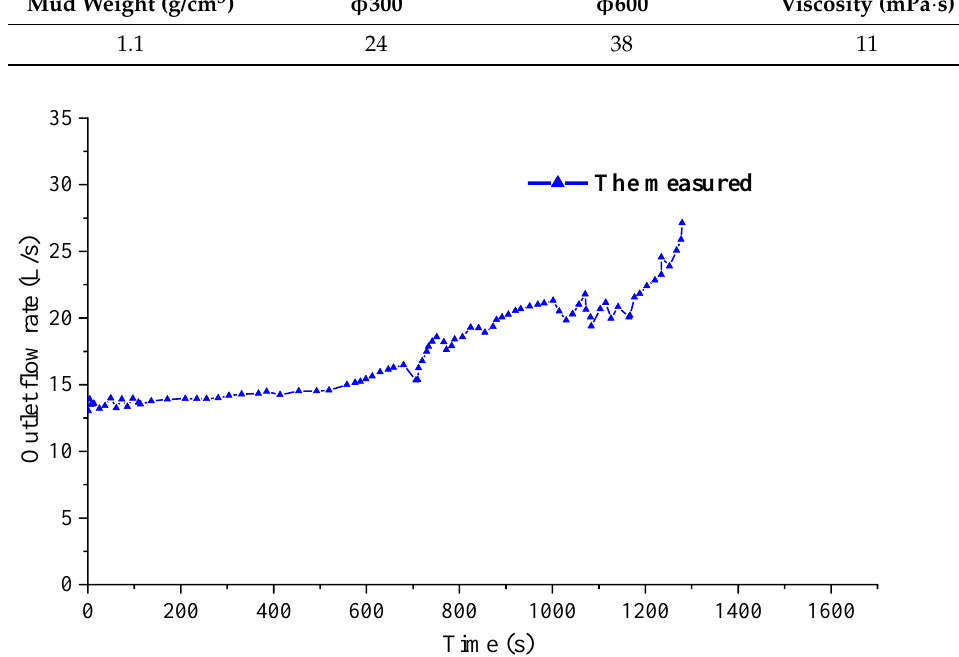
Figure 9. Outlet flow rate measured in real time during the overflow for well L. The parameters of well L were used for the formation-wellbore coupled two-phase flow simulations, to derive the outlet flow data during the underbalanced pressure gas kick and the gravity displacement gas kick, as shown in Figure 10. The data obtained from the simulation are composed into a time series as the judgment reference, where the reference time series of the underbalanced pressure gas kick is 𝐴 = {𝑎 1 , 𝑎 2 , ⋯ , 𝑎 𝑖 , ⋯ 𝑎 𝑚 } and the reference time series of the gravity displacement gas kick is 𝐵 = {𝑏 1 ,𝑏 2 ,⋯,𝑏 𝑗 ,⋯ 𝑏 𝑛 } . Figure 11 illustrates the time series of the judgment reference time series A and B and time series C , to be judged.